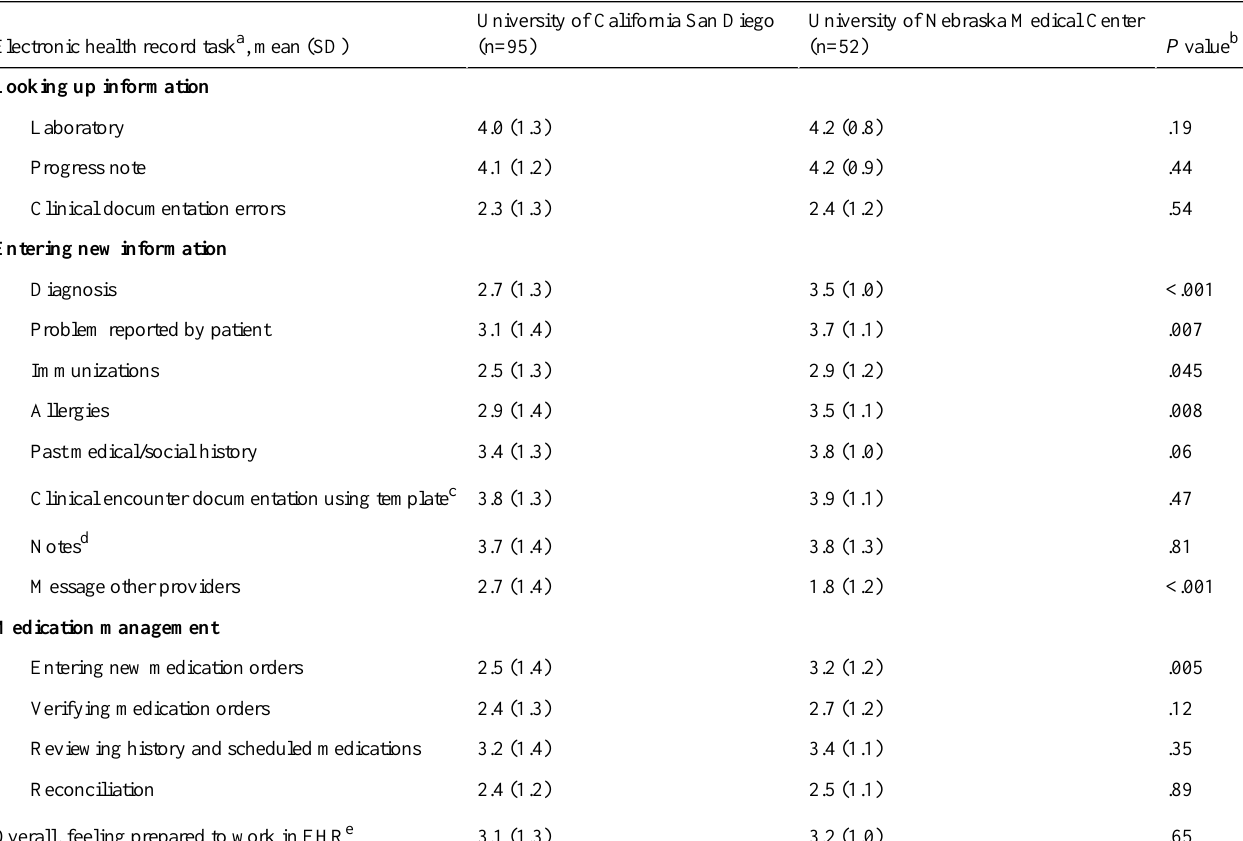
Table 3. Average self-reported feeling of comfort with using various components of the electronic health record by